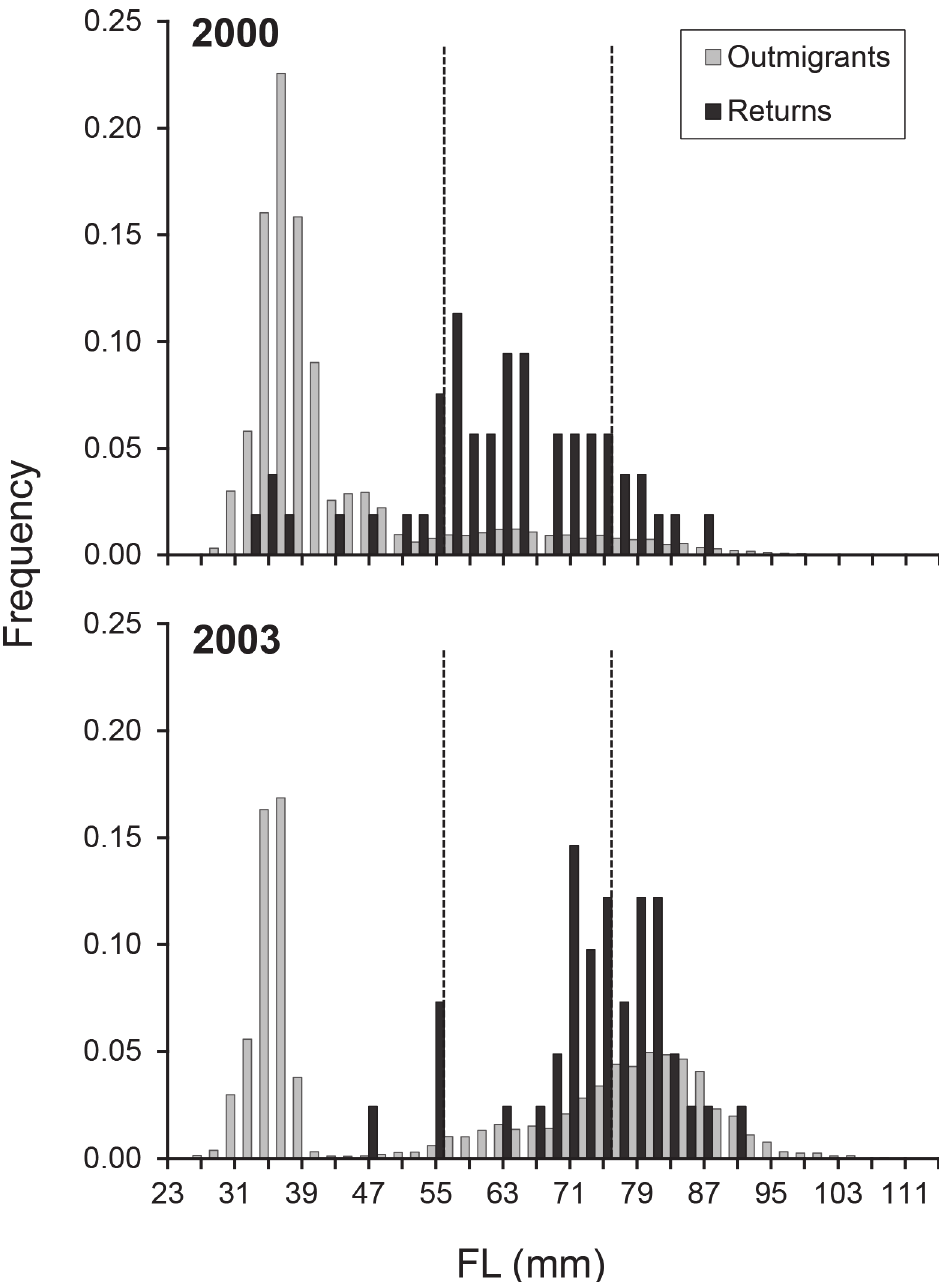
Fig 6. Size-at-outmigration of the juveniles and surviving adults that left freshwater in 2000 and 2003. Size-frequency distributions showing the fork length (FL) at which juveniles outmigrated from the Stanislaus River in 2000 and 2003 (grey bars) and the reconstructed size-at-outmigration of the returning (i.e. “ successful ” ) adults from the same cohort (black bars). FLs given in 2mm bins (where the x-axis represents < that value, e.g. "55" = FL 53.01 – 55.0mm). Size classes used to categorize fry, parr and smolt outmigrants are indicated by dashed